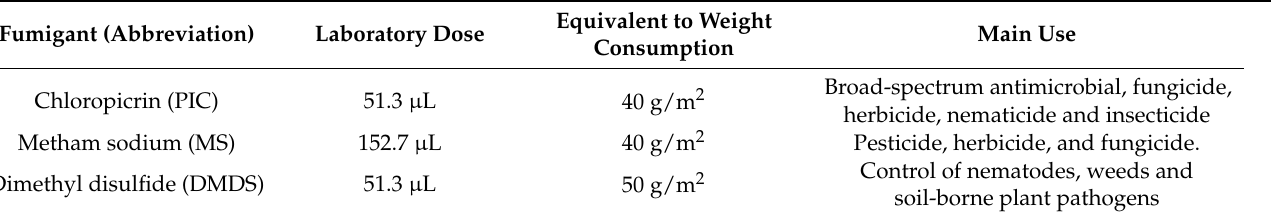
Table 1. Doses of fumigants used in laboratory